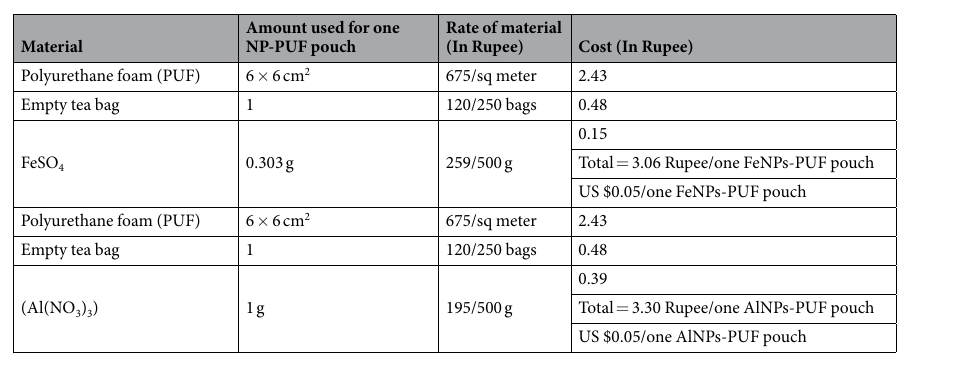
Table 3. Detailed cost of one NPs-PUF filter